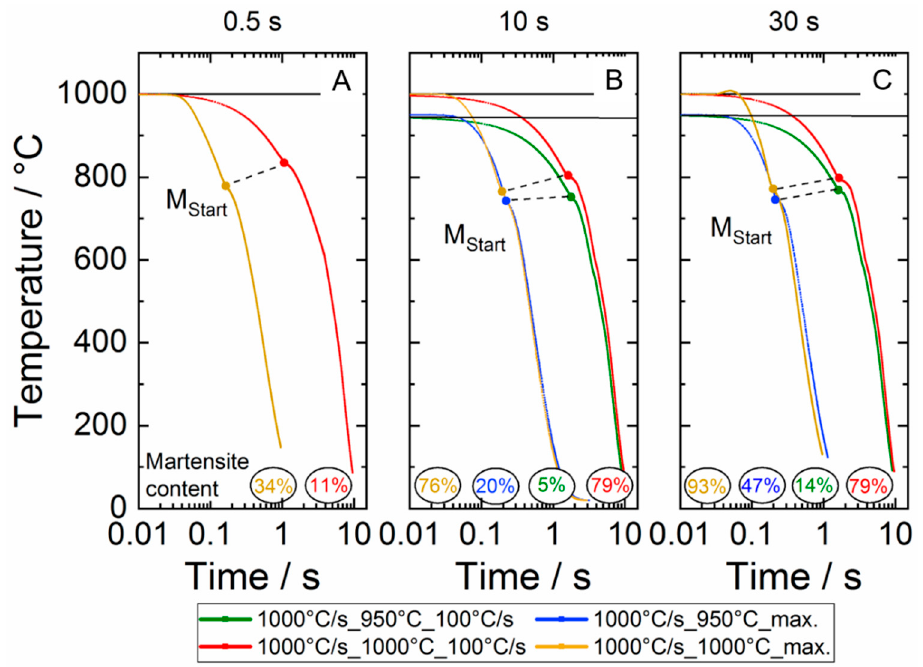
Figure 11. Time–temperature transformation relationship of the alloy Ti6Al4V ELI during continuous cooling down using a controlled cooling rate of 100 ◦ C / s and maximum cooling (cooling rates above 1000 ◦ C / s—see Figure 4) for holding times of 0.5 s ( A ), 10 s ( B ) and 30 s ( C ), respectively. The buckling points clearly indicate the martensite start